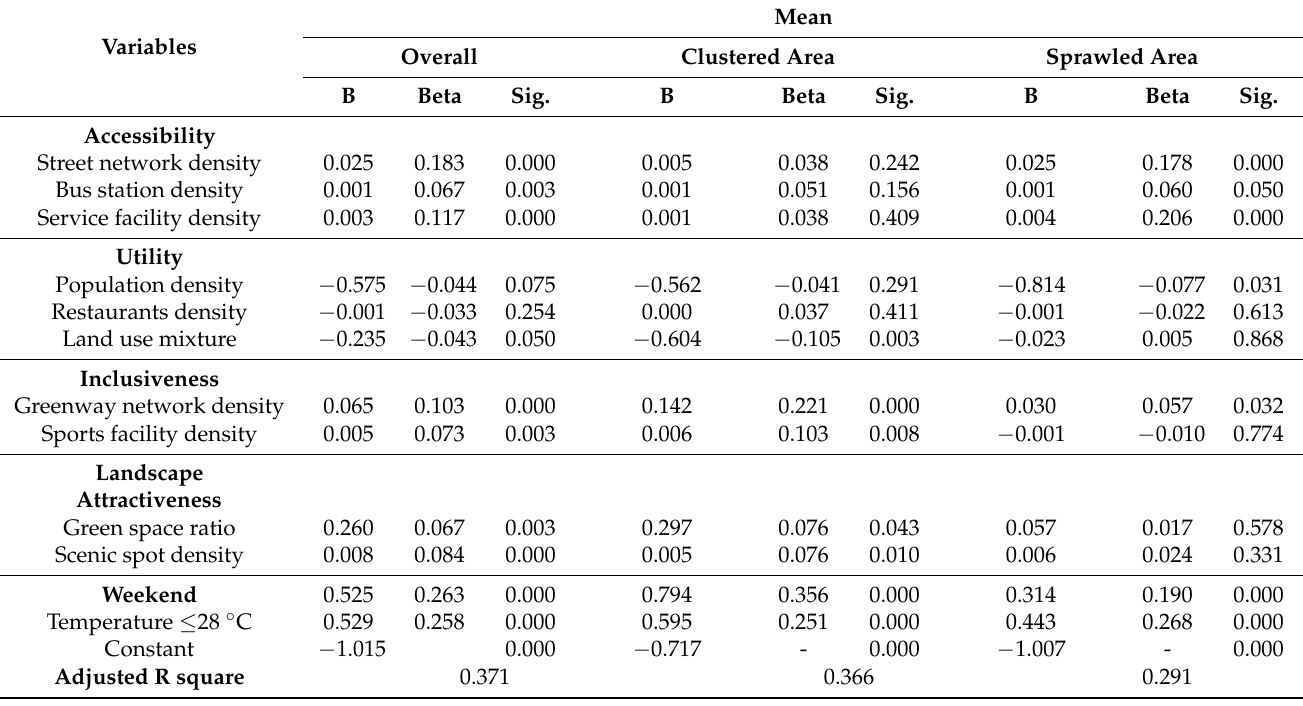
Table 8. Regression models and